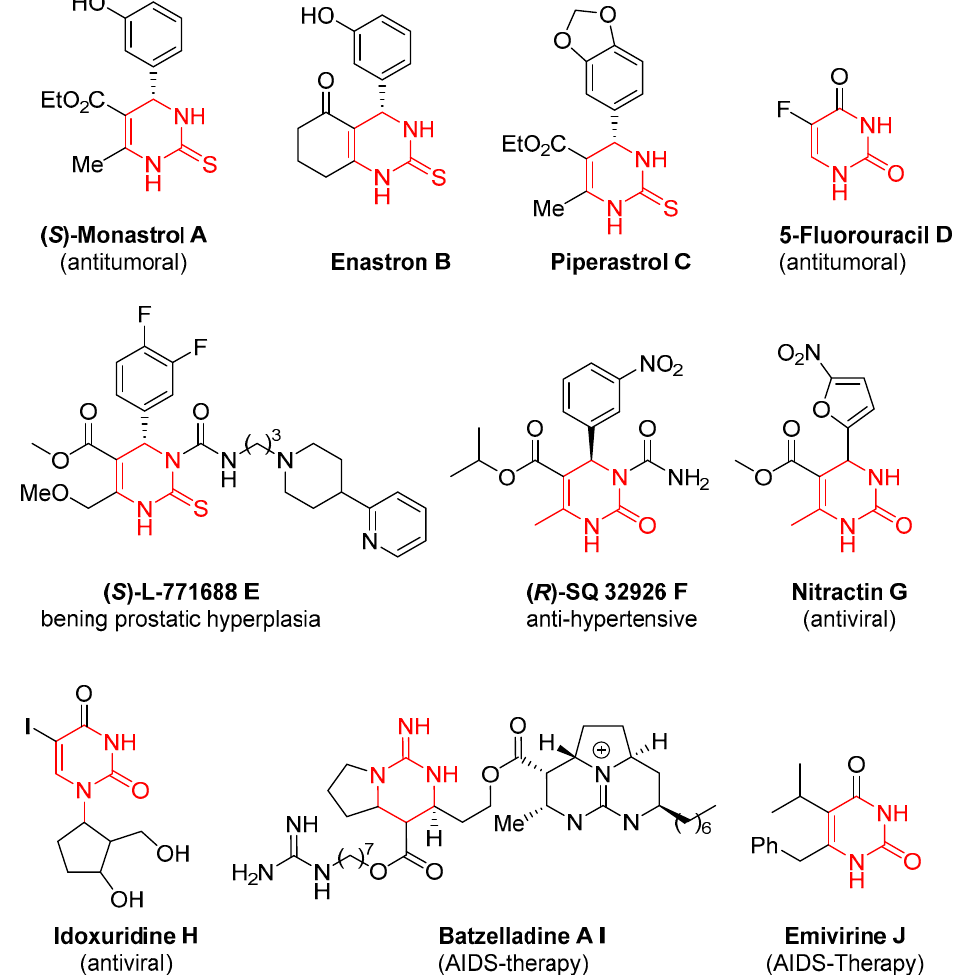
Figure 1. Representative examples ( A – J ) of biologically active DHPM ‐ derivatives.